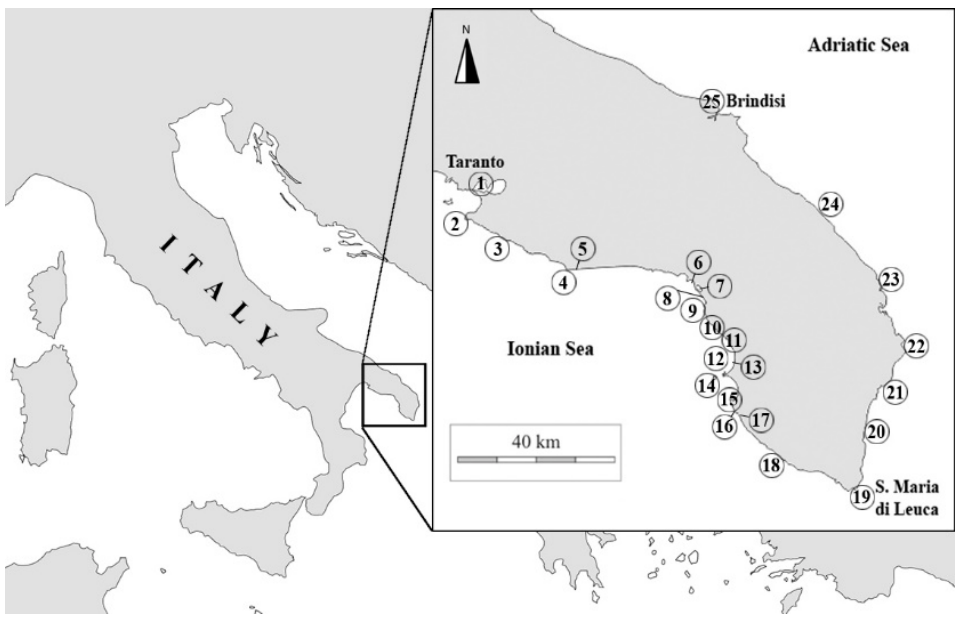
Figure 1. Map of the Salento Peninsula indicating the sampling localities; the box highlights the Salento Peninsula at a higher magnification. Numbers refer to sampling stations reported in Table 1. Table 1. Number, name, geographic coordinates (latitude and longitude), and the depth range of the sampled stations.